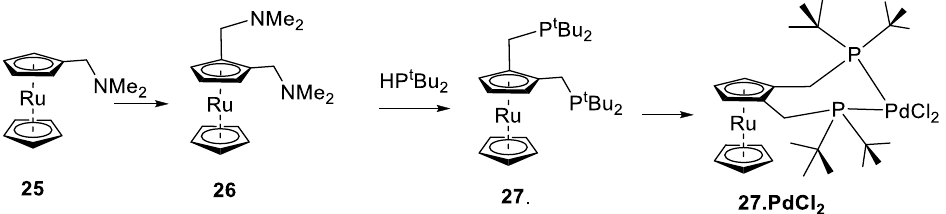
Figure 21. Schematic of the preparation of the 1,2-bis-(N,N-dimethylaminomethyl)ruthenocene, 26 , 1,2-bis-[di-(tert-butyl)phosphano)]ruthenocene, rubutphos , 27 , and the complex 27.PdCl 2 [69].